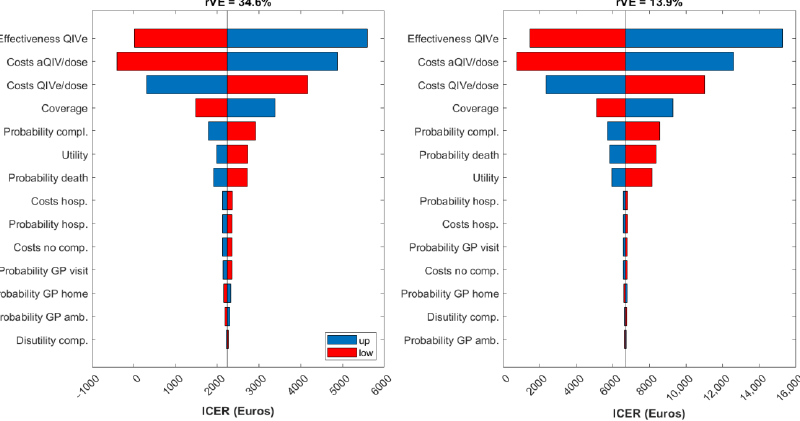
Figure 2. Tornado diagrams for the ICER from the payer perspective. aQIV = adjuvanted quadrivalent influenza vaccine; amb. = ambulatory; comp. = complications; hosp. = hospitalization; QIVe = standard-dose quadrivalent influenza vaccine; rVE = relative vaccine effectiveness. Results from the PSA indicate that from the payer’s perspective , the probability of aQIV being cost-effective compared with QIVe is 65% for the scenario using rVE = 34.6%, and 52.4% for the scenario using rVE = 13.9%. Figure 3 shows the results from the PSA as scatter plots (incremental QALYs versus incremental costs) from the payer perspective. Because of the nonlinearities of the system the majority of the simulations have a number of infected individuals lower than the mean.